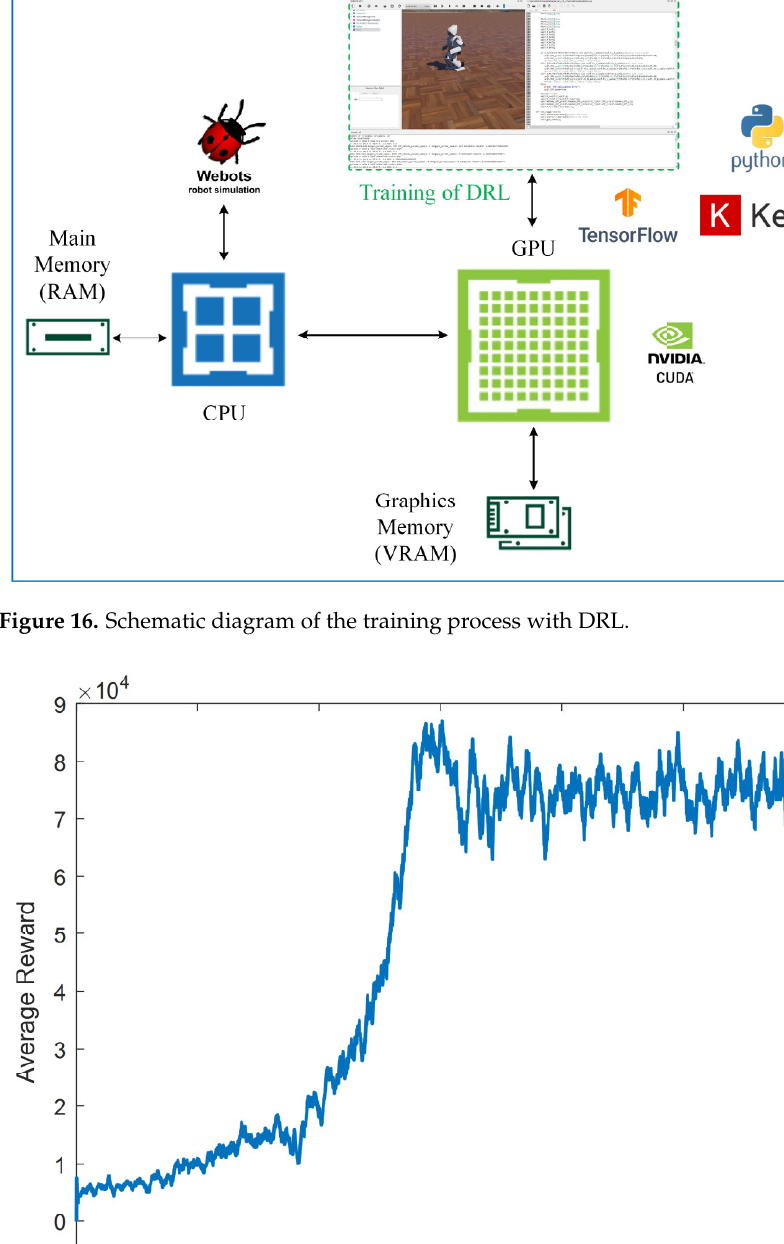
Figure 16. Schematic diagram of the training process with DRL.